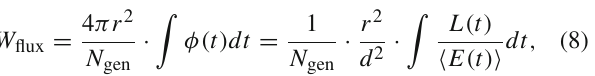
The limited size of the simulated volume, chosen to